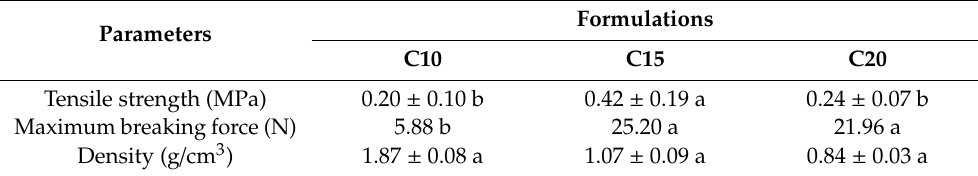
Table 2. Mechanical properties and densities of foams based on potato by-products.